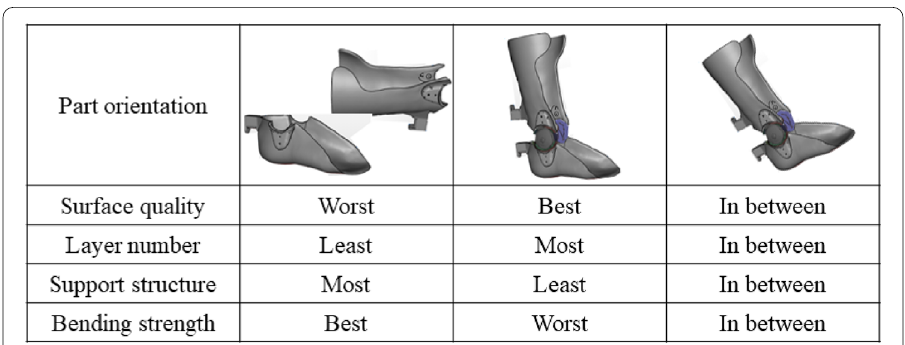
Fig. 5 Impact of part orientation in AM AFO. *Part orientation in the previous study was presented via the 3D CAD model of NIH